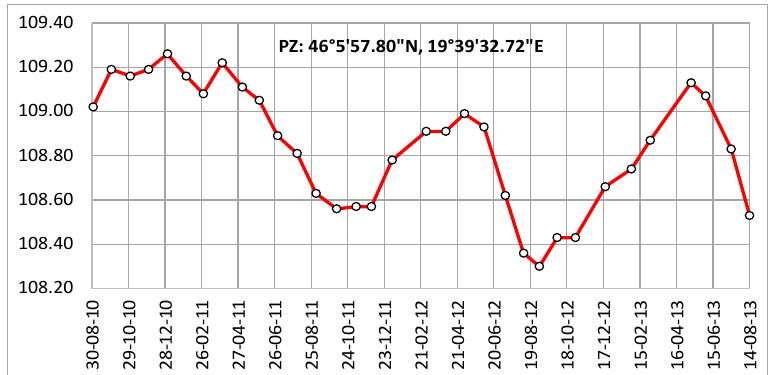
Figure 6. Results of groundwater level monitoring around the Cathedral [5].